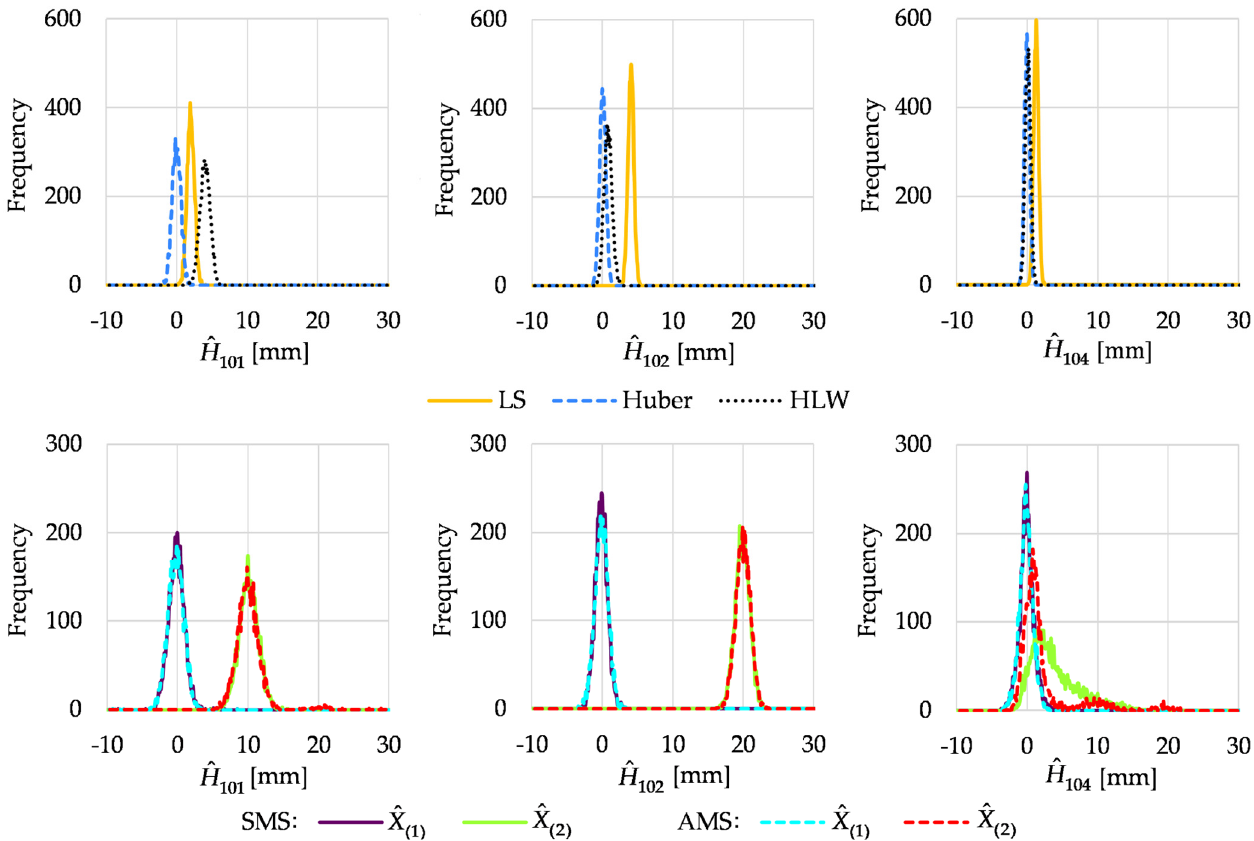
Figure 2. Histograms of estimated point heights in Variant I.